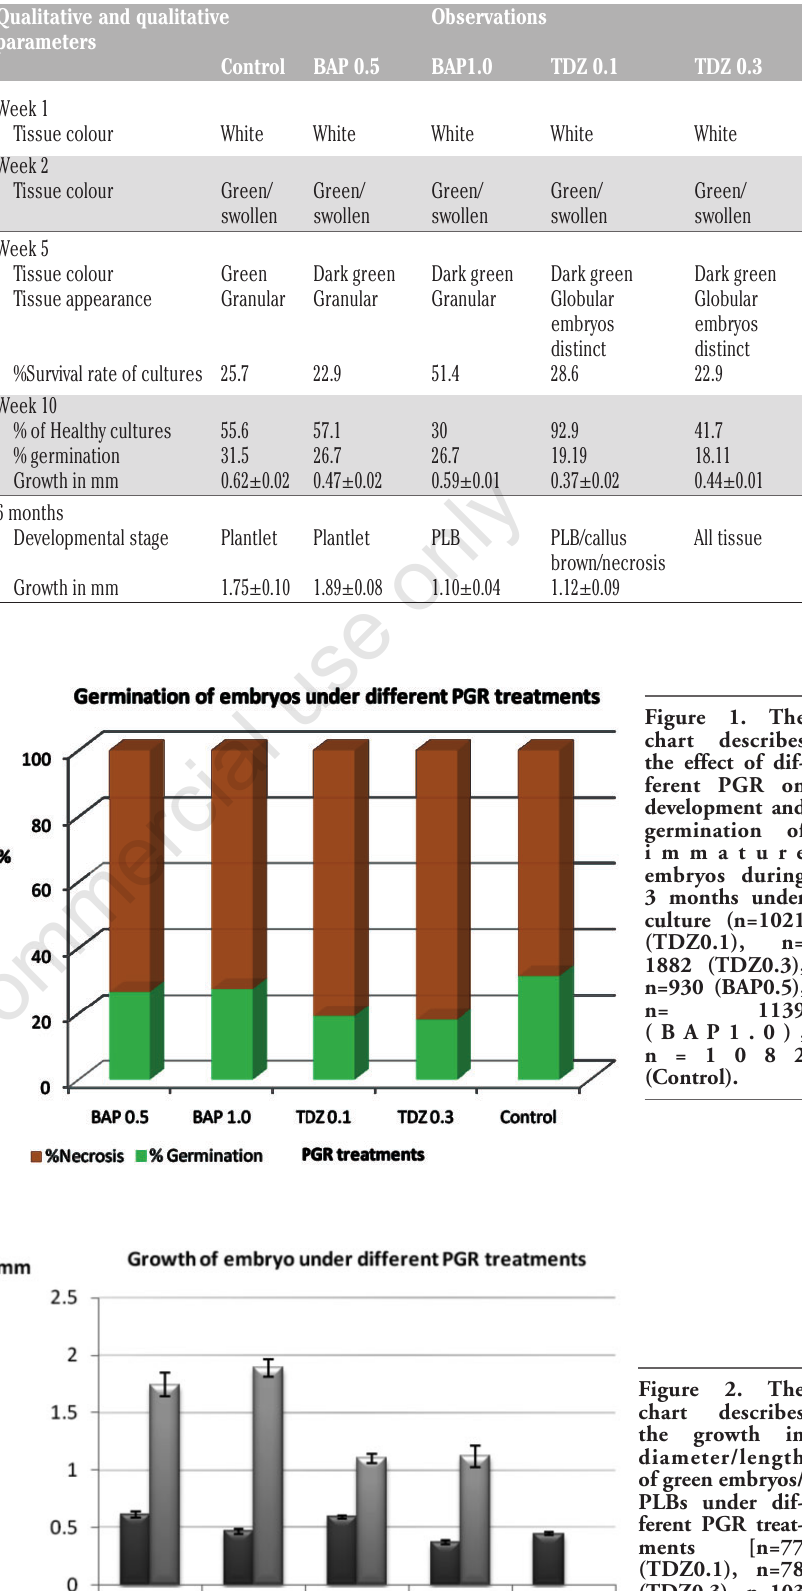
Table 1. Qualitative and Quantitative data were collected to assess and compare growth under different PGR treatments. Qualitative and qualitative Observations